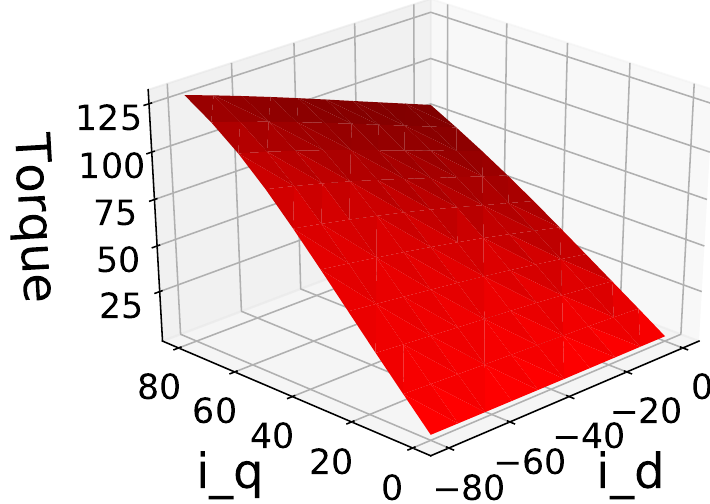
Figure 12. Torque flux map with dq -axis